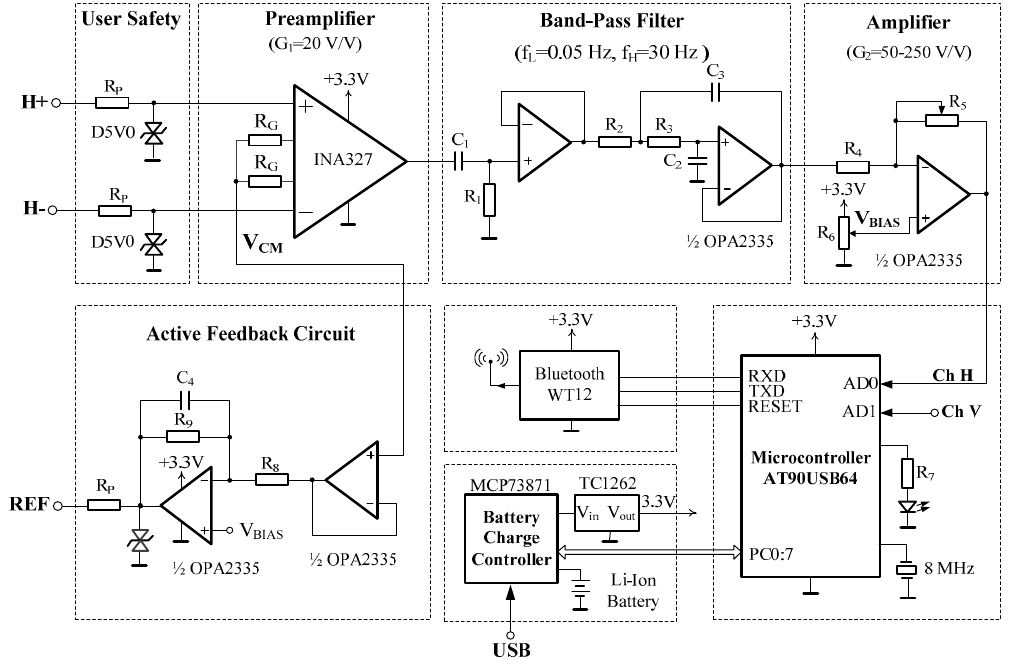
Figure 3. Electrical schematic of the hardware device (only the horizontal channel is shown).